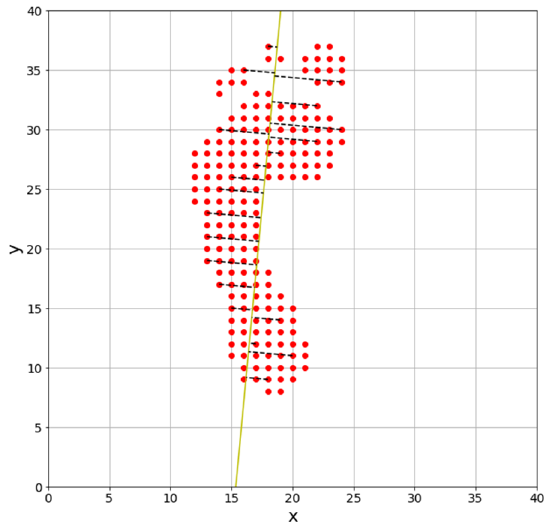
Figure 9. Angular measurement result using total least squares procedure.